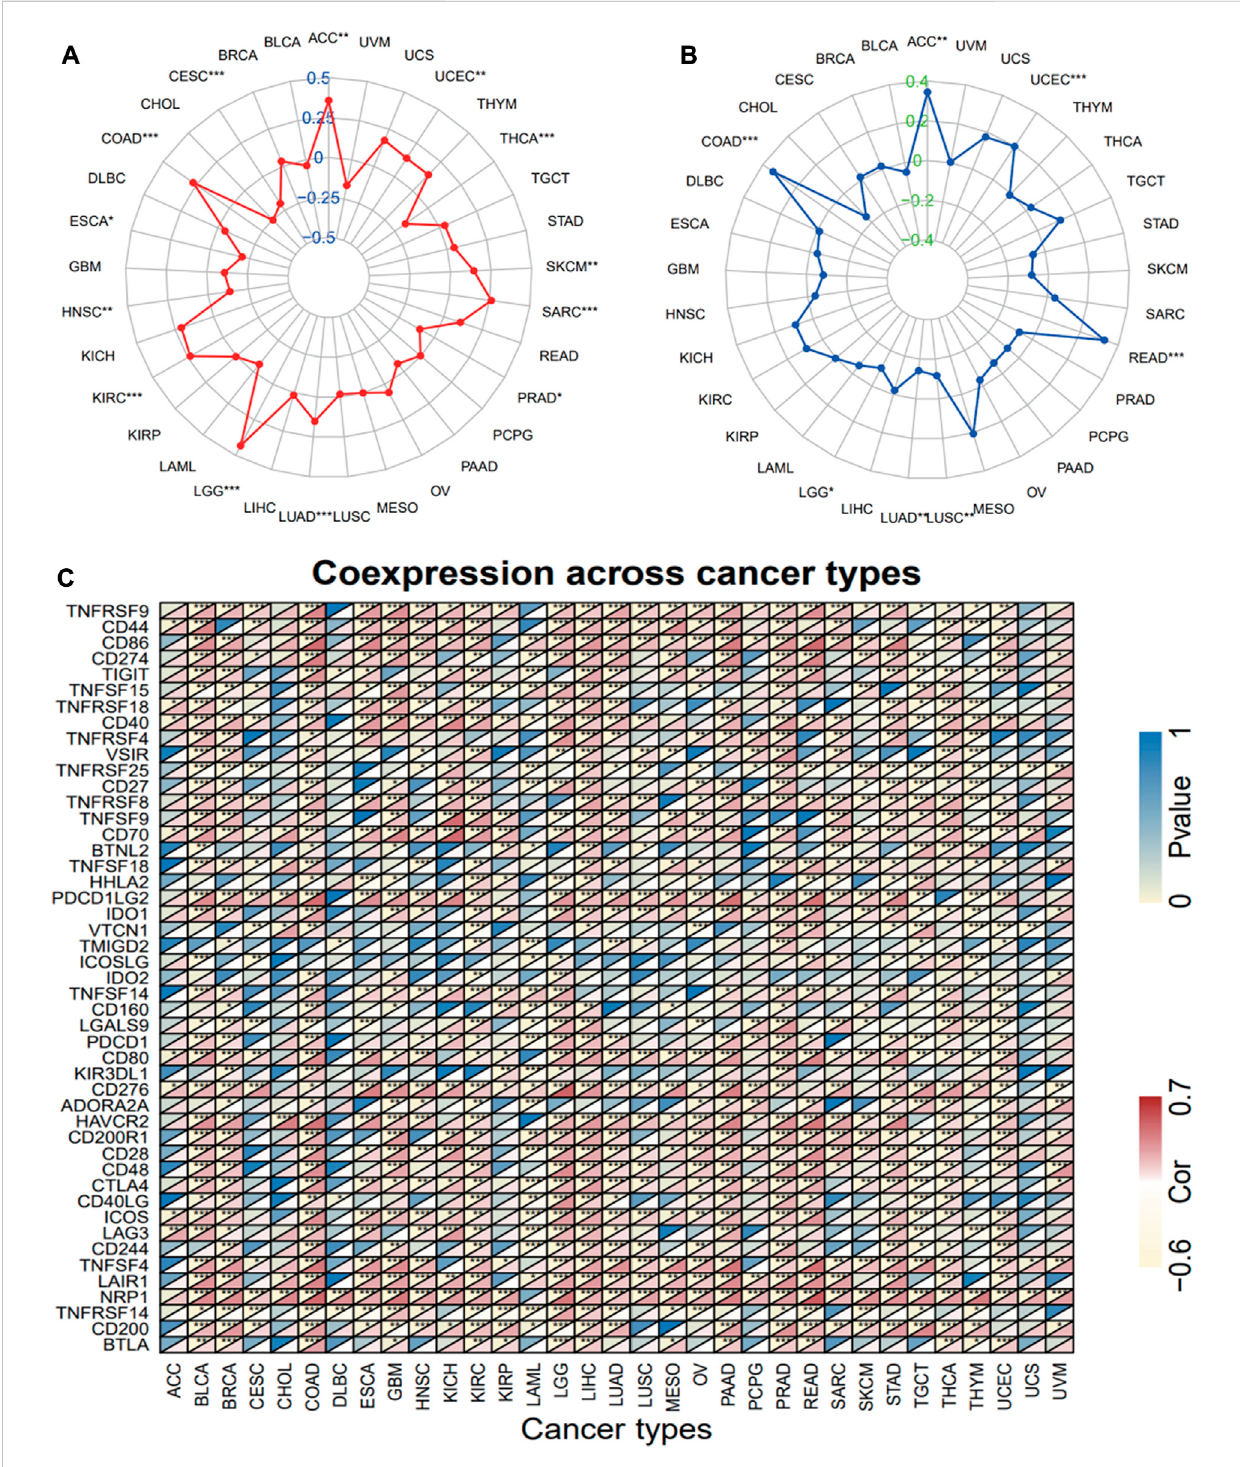
FIGURE 5 CorrelationbetweenTMB,MSI,andICGsandIKBIPexpression. (A) RelationshipbetweenTMBandIKBIPexpression. (B) MSIandIKBIPexpressionare correlated. (C) Relationship between ICGs and IKBIP